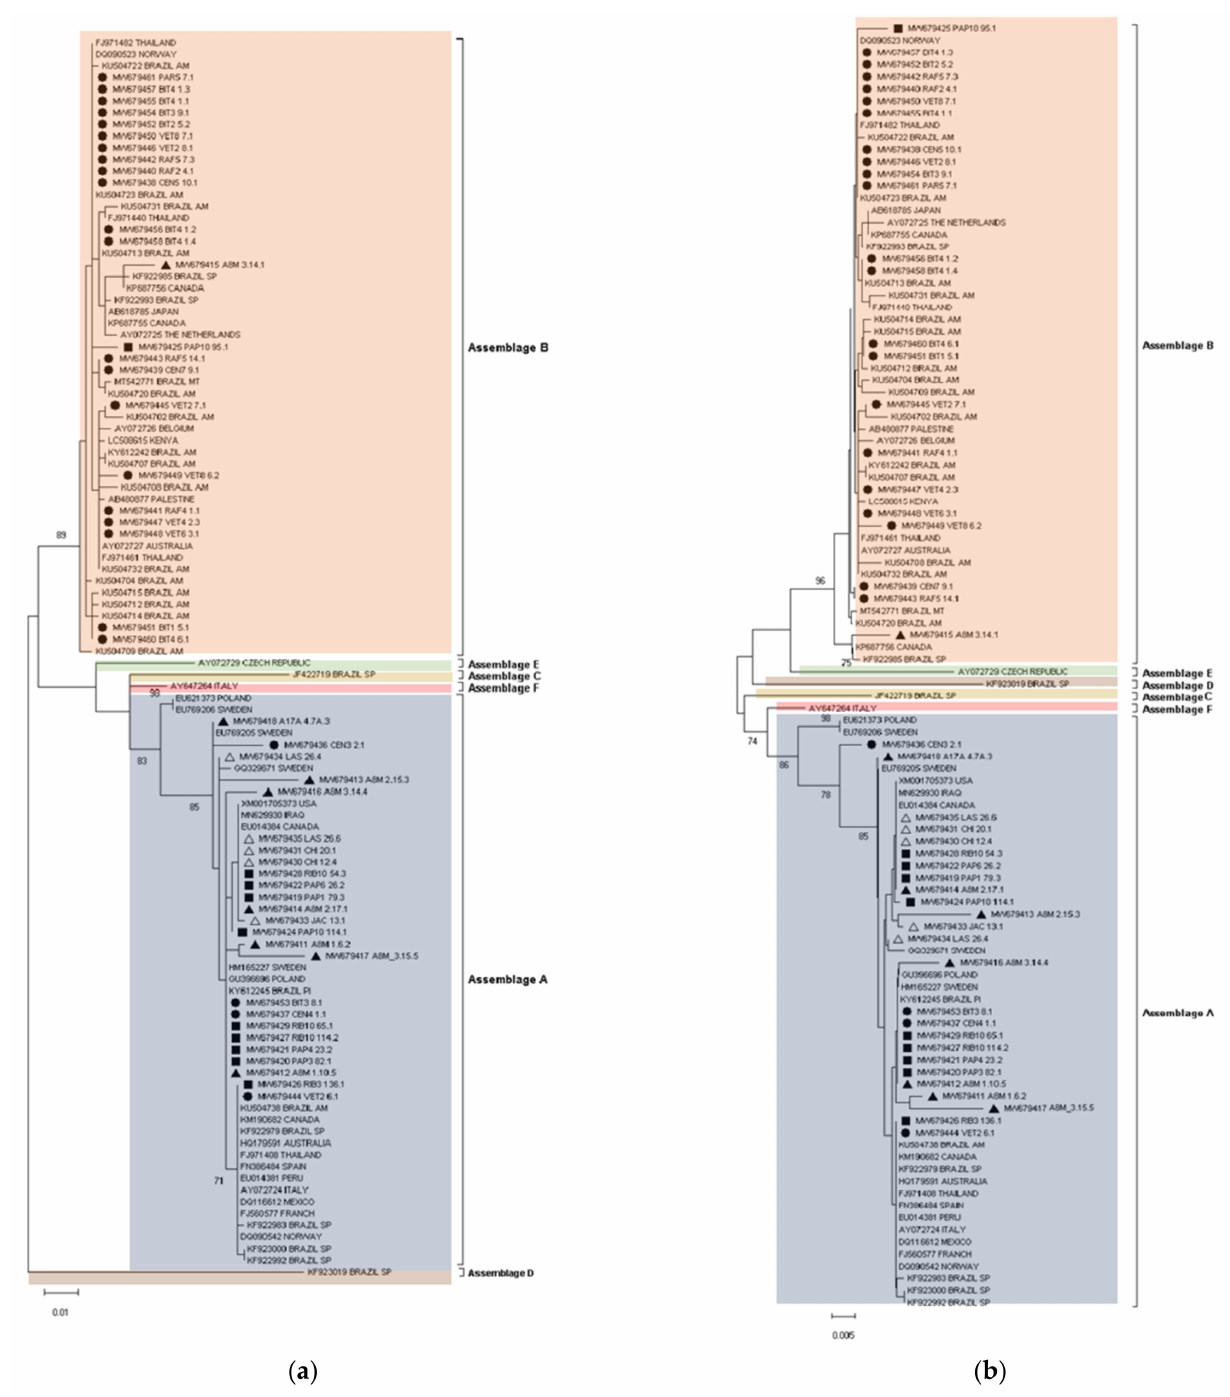
Figure 4. ( a ) Maximum likelihood and ( b ) neighbor joining trees inferred from Giardia duodenalis β -giardin locus (592 bp, n = 106). Support for the branching order was determined by 1000 bootstrap replicates, and only values >70% are reported. ● : Bagre—Amazon; : Cachoeiras de Macacu— Atlantic Forest; ∆ : São João do Piauí—Caatinga; ▲ : Teresina—Cerrado biome. GenBank accession numbers are indicated. Further details of reference strains can be found in Supplementary Table